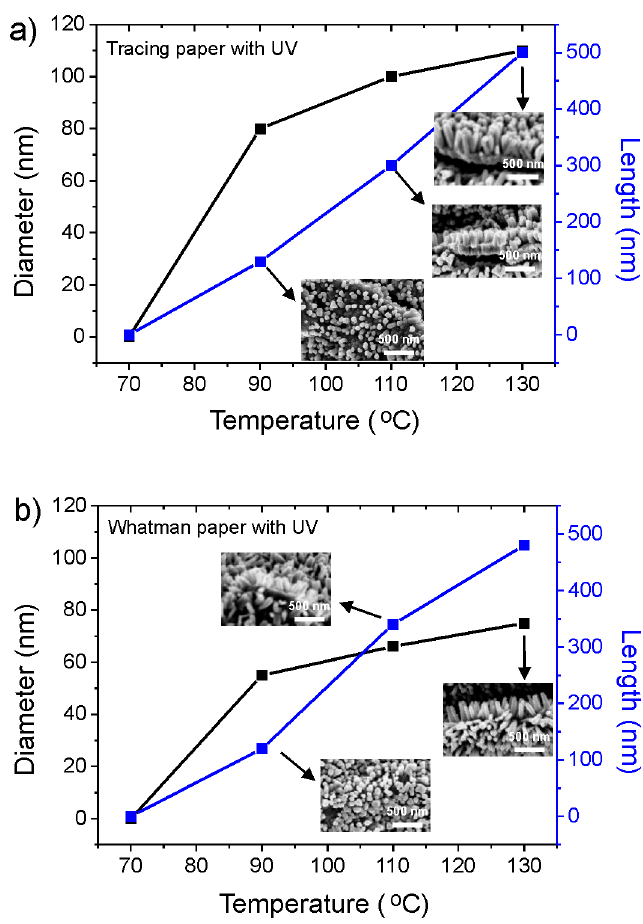
Figure 8. Behavior of length and diameter of the ZnO nanorods as a function of temperature for ( a ) tracing paper and ( b ) Whatman paper. The insets reveal the corresponding SEM images.